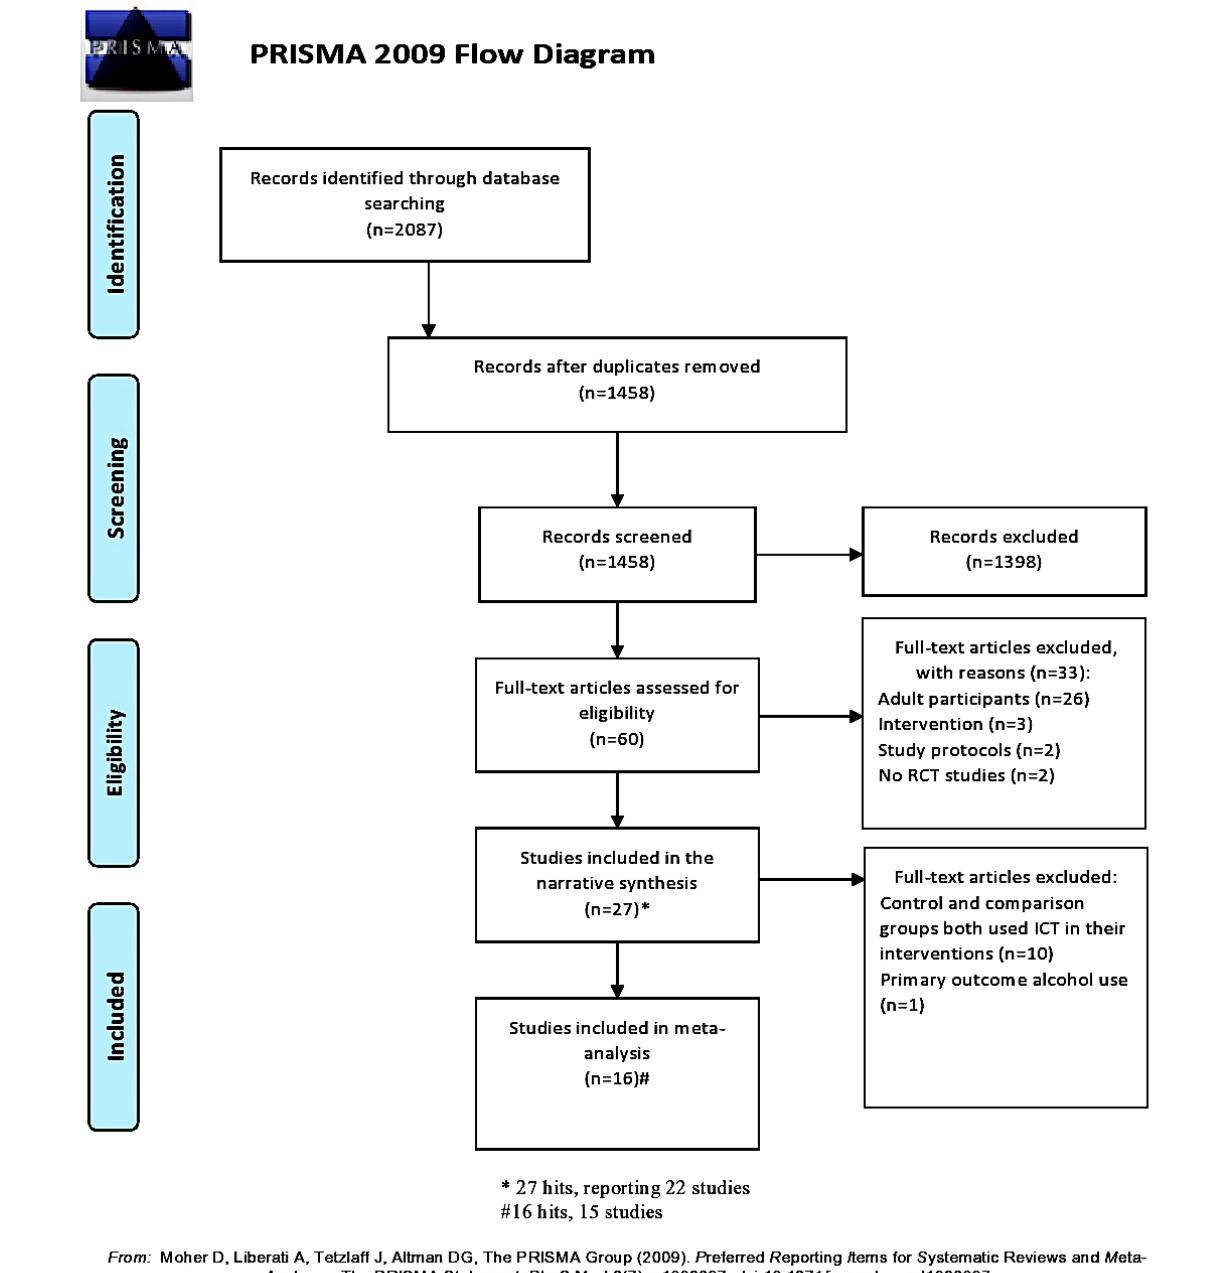
Figure 1. Preferred reporting items for systematic reviews and meta-analysis (PRISMA) flow